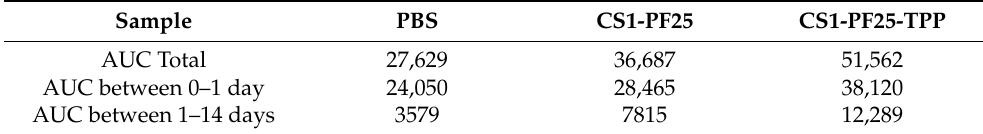
Table 3. Summary of area under the curve values (AUC—area under the